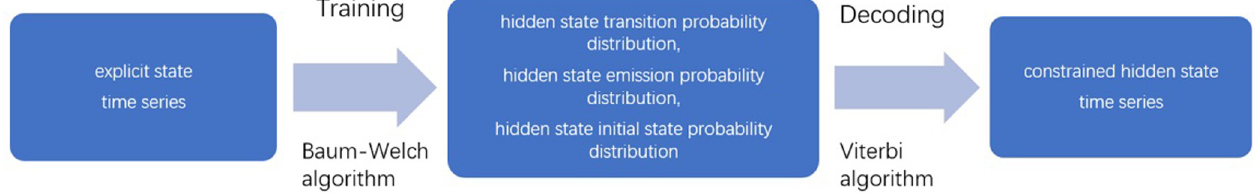
Fig 1. The model training and decoding process of the SDC-HMM. To demonstrate the steps of training and decoding we use the Baum-Welch algorithm and Viterbi algorithm respectively. Firstly, the explicit state time series are trained into the hidden state transition probability distribution, the hidden state emission probability distribution, and the hidden state initial state probability distribution. Then we perform the Viterbi algorithm in decoding these probability distributions into the constrained hidden time series.